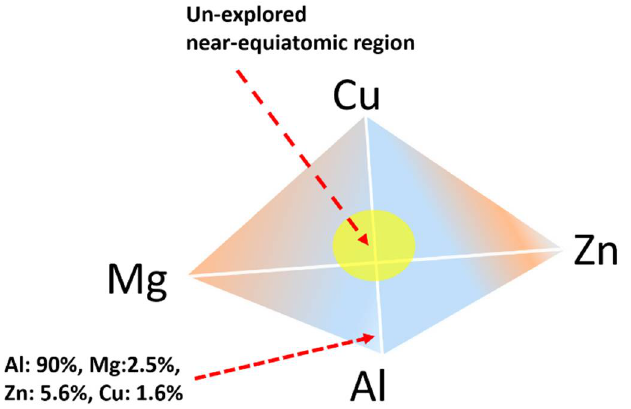
Figure 7. Quaternary phase diagram illustrating conventional (AlMgZnCu alloy) and HEA systems. The central region remains unexplored in most multicomponent element systems.